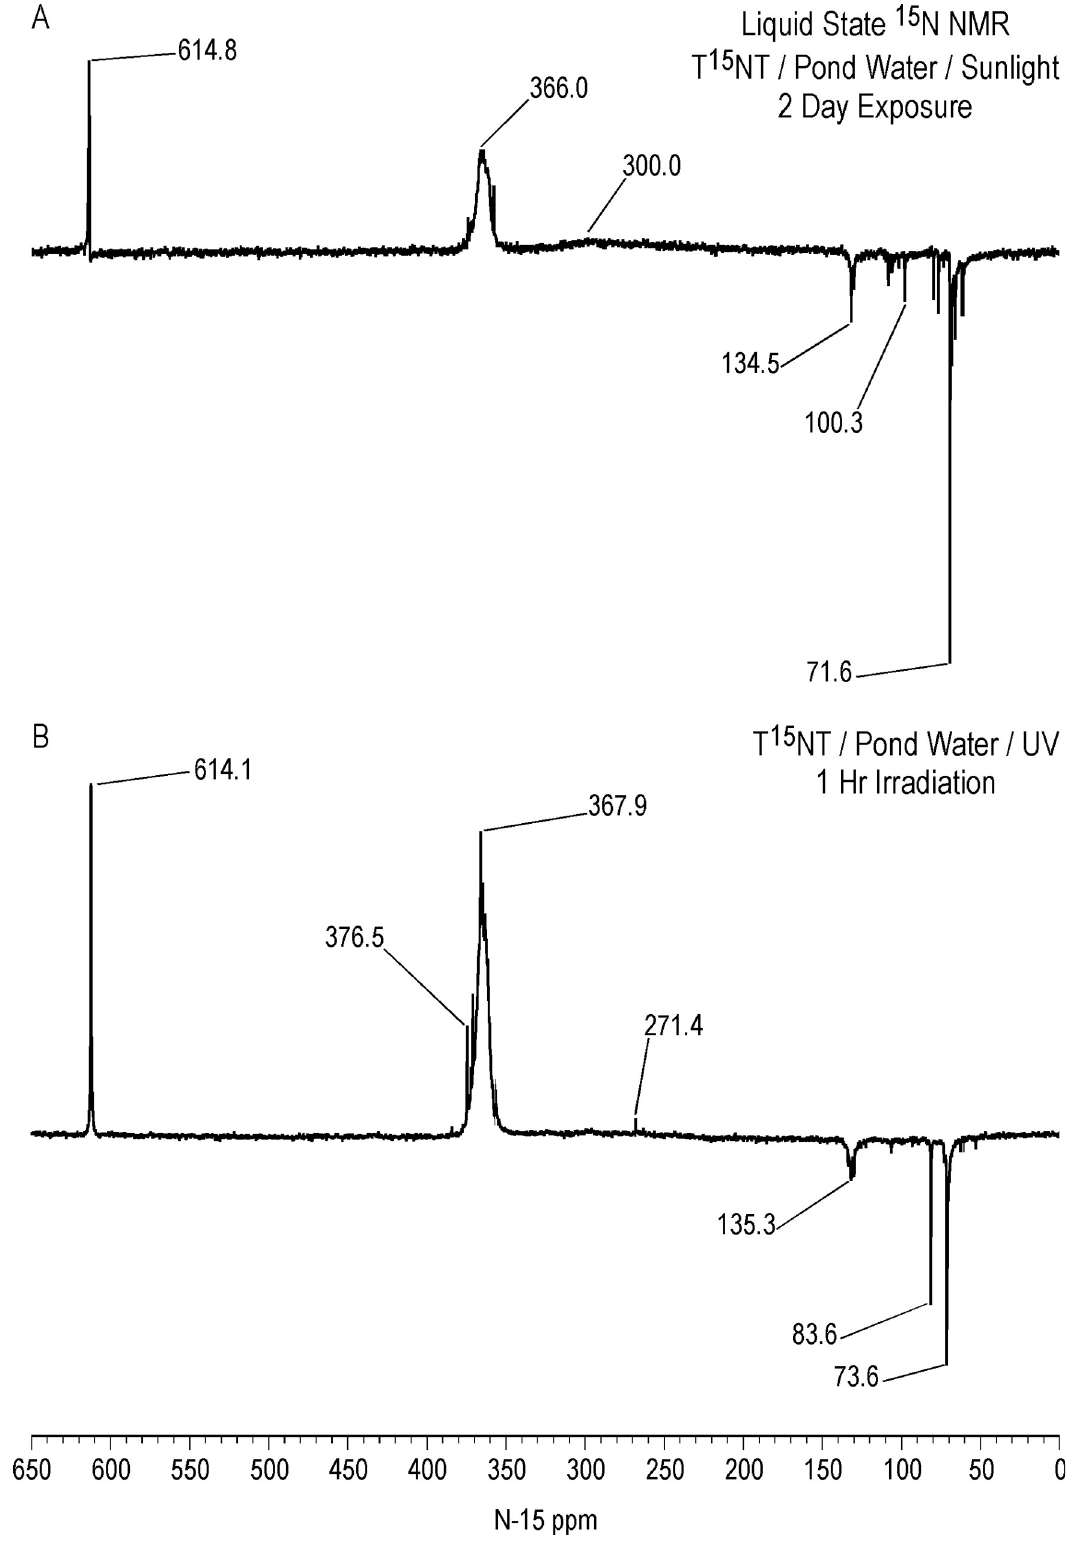
Fig 25. Liquid state N-15 NMR spectra of T 15 NT. LB = 3.0 Hz. A. Sunlight irradiation in pond water, ACOUSTIC spectrum. B. Lamp irradiation in pond water, continuous decoupled spectrum. https://doi.org/10.1371/journal.pone.0224112.g025 PLOS ONE | https://doi.org/10.1371/journal.pone.0224112 October 22,